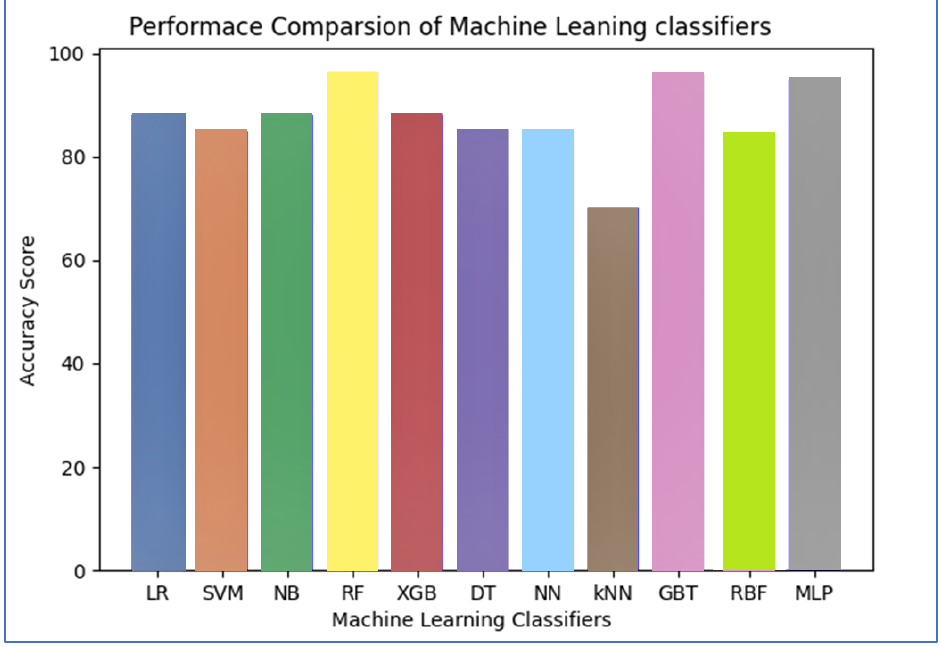
Figure 13. ML Classifiers Accuracy.